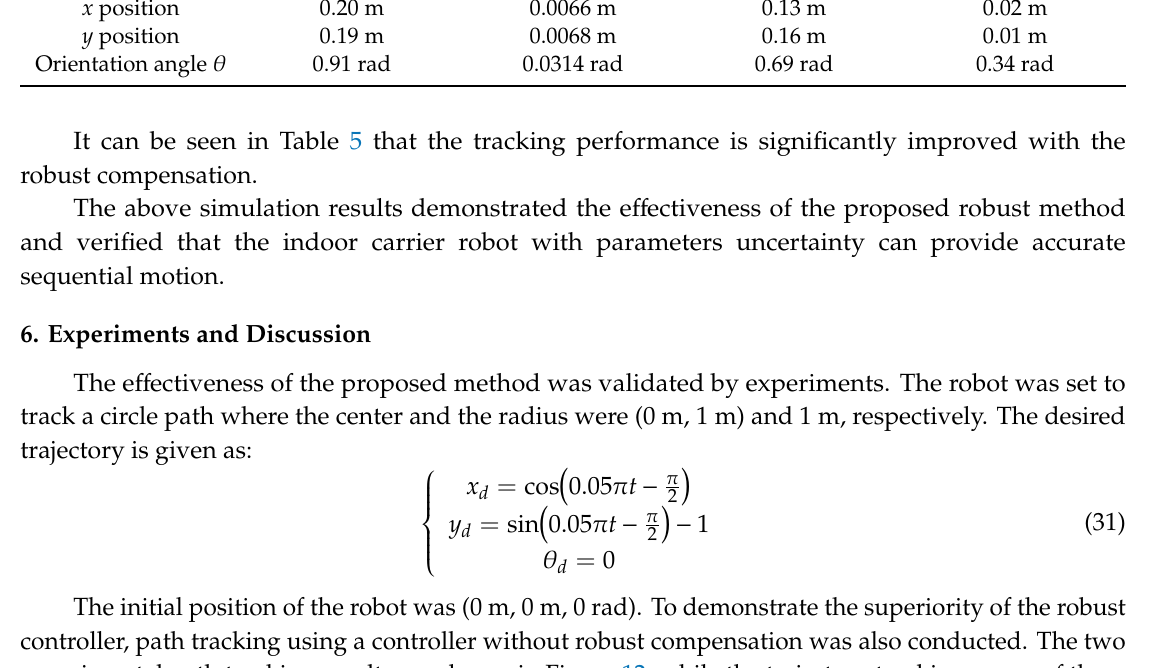
Figure 11. Trajectory tracking error for the astroid curves (with robust compensation: ( a 1 ) x position; ( b 1 ) y position; and ( c 1 ) orientation θ ) (non-robust compensation: ( a 2 ) x position; ( b 2 ) y position ( c 2 ); and orientation θ ).